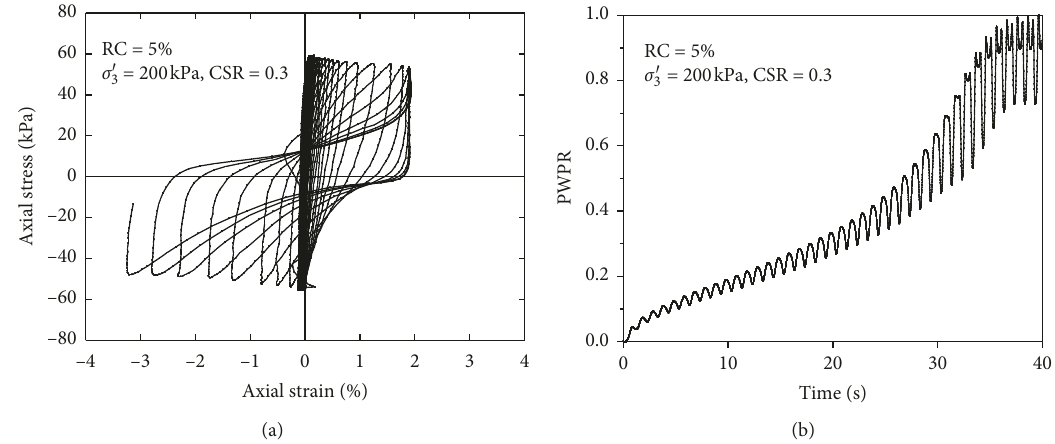
Figure 10: Typical experimental results for RC � 5%, σ histories of